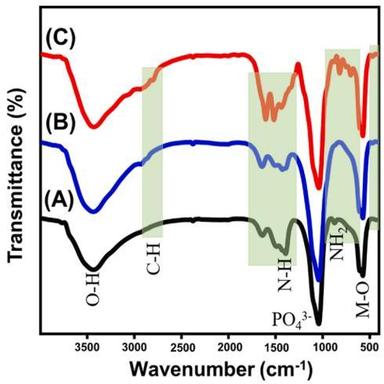
FT-IR spectrum of the Mg.HPA NFs before the adsorption processes (A), after the adsorption of Zn (II) (B), and after the adsorption of the MG dye (C).